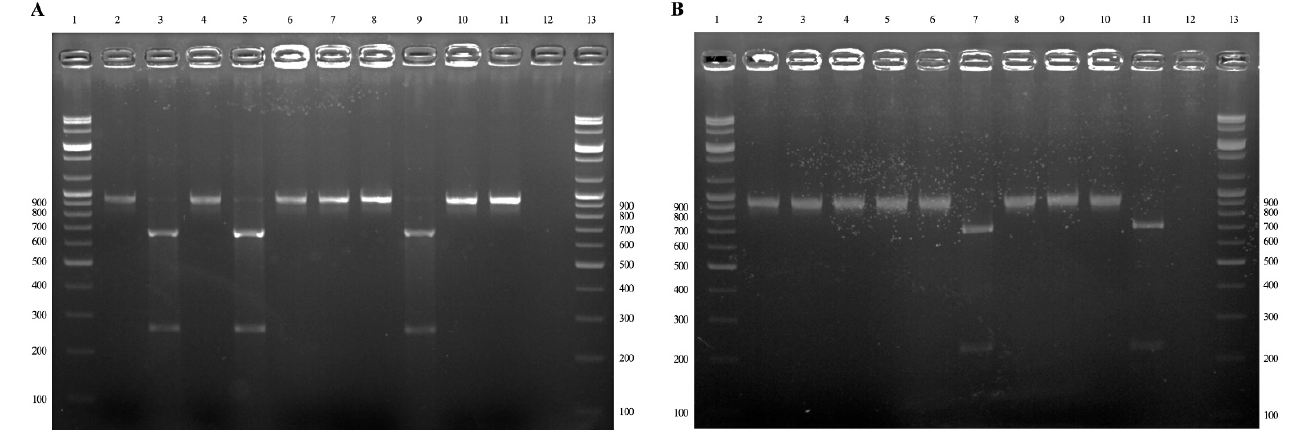
Figure 2. Restriction fragment length polymorphism (RFLP) assay and Anaplasma species identification. ( A ) RFLP analysis using Ale I enzyme for PCR products. Lanes 1 and 13: 100 bp ladder; lanes 2 and 3: A. bovis PCR products from horse blood samples before (924 bp) and after (660 and 264 bp) Ale I restriction digestion; lanes 4 and 5: A. bovis PCR products from horse lung tissue samples